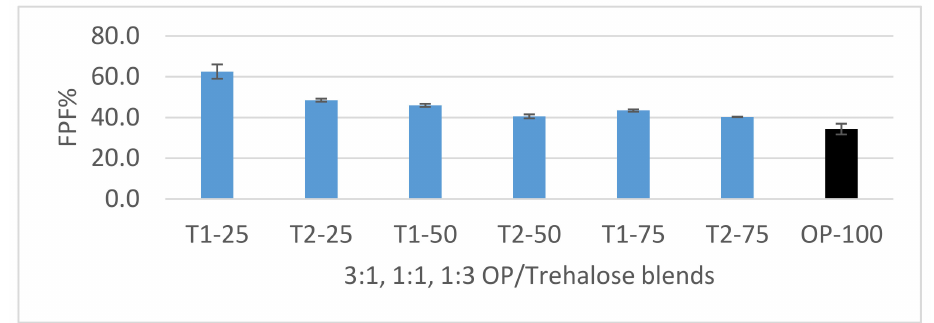
Figure 7. FPF% chart of 3:1, 1:1, and 1:3 OP / trehalose blends and diluent free formulation (OP-100) (black bar) aerosolized by the UNI-haler. Blends (blue bars) are arranged according to trehalose grade and ratio from left to right; 25% micronized trehalose (T1-25), 25% milled trehalose (T2-25), 50% micronized trehalose (T1-50), 50% milled trehalose (T2-50), 75% micronized trehalose (T1-75), and 75% milled trehalose (T2-75). Error bars based on calculated standard deviation from mean ( n = 3).